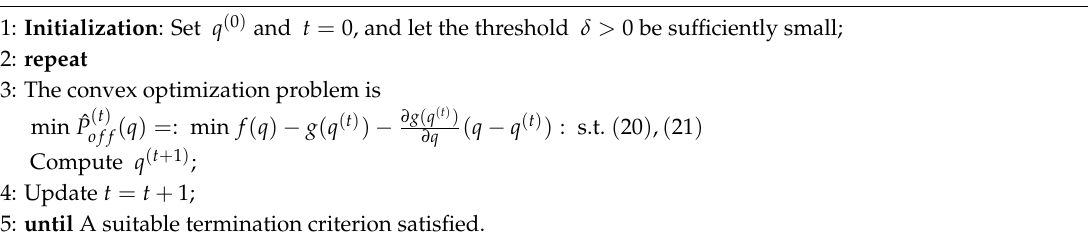
Algorithm 1. DC algorithm for cooperative crossing cache placement optimization